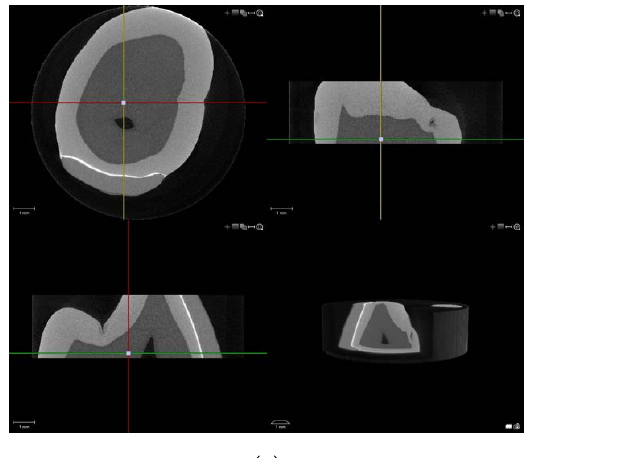
Figure 4. Process of setting the intervals for scanning: ( a ) positioning of the specimen and measurements; ( b ) segments chosen for micro-CT scanning.